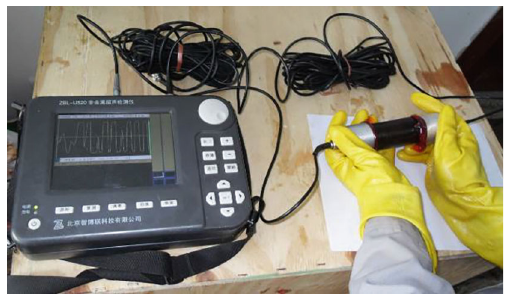
Figure 8: Ultrasonic detection on oil shale samples after periodic freeze-thaw